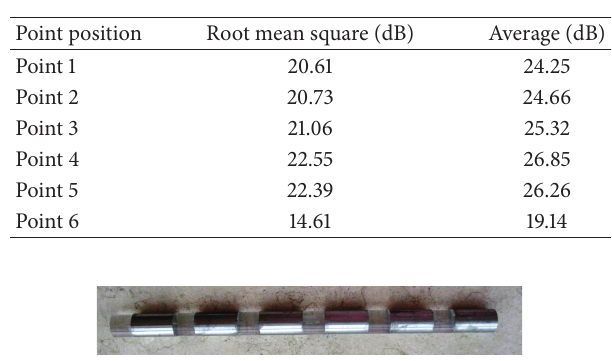
Figure 1: The experimental phononic crystal beam made of PMMA and steel.